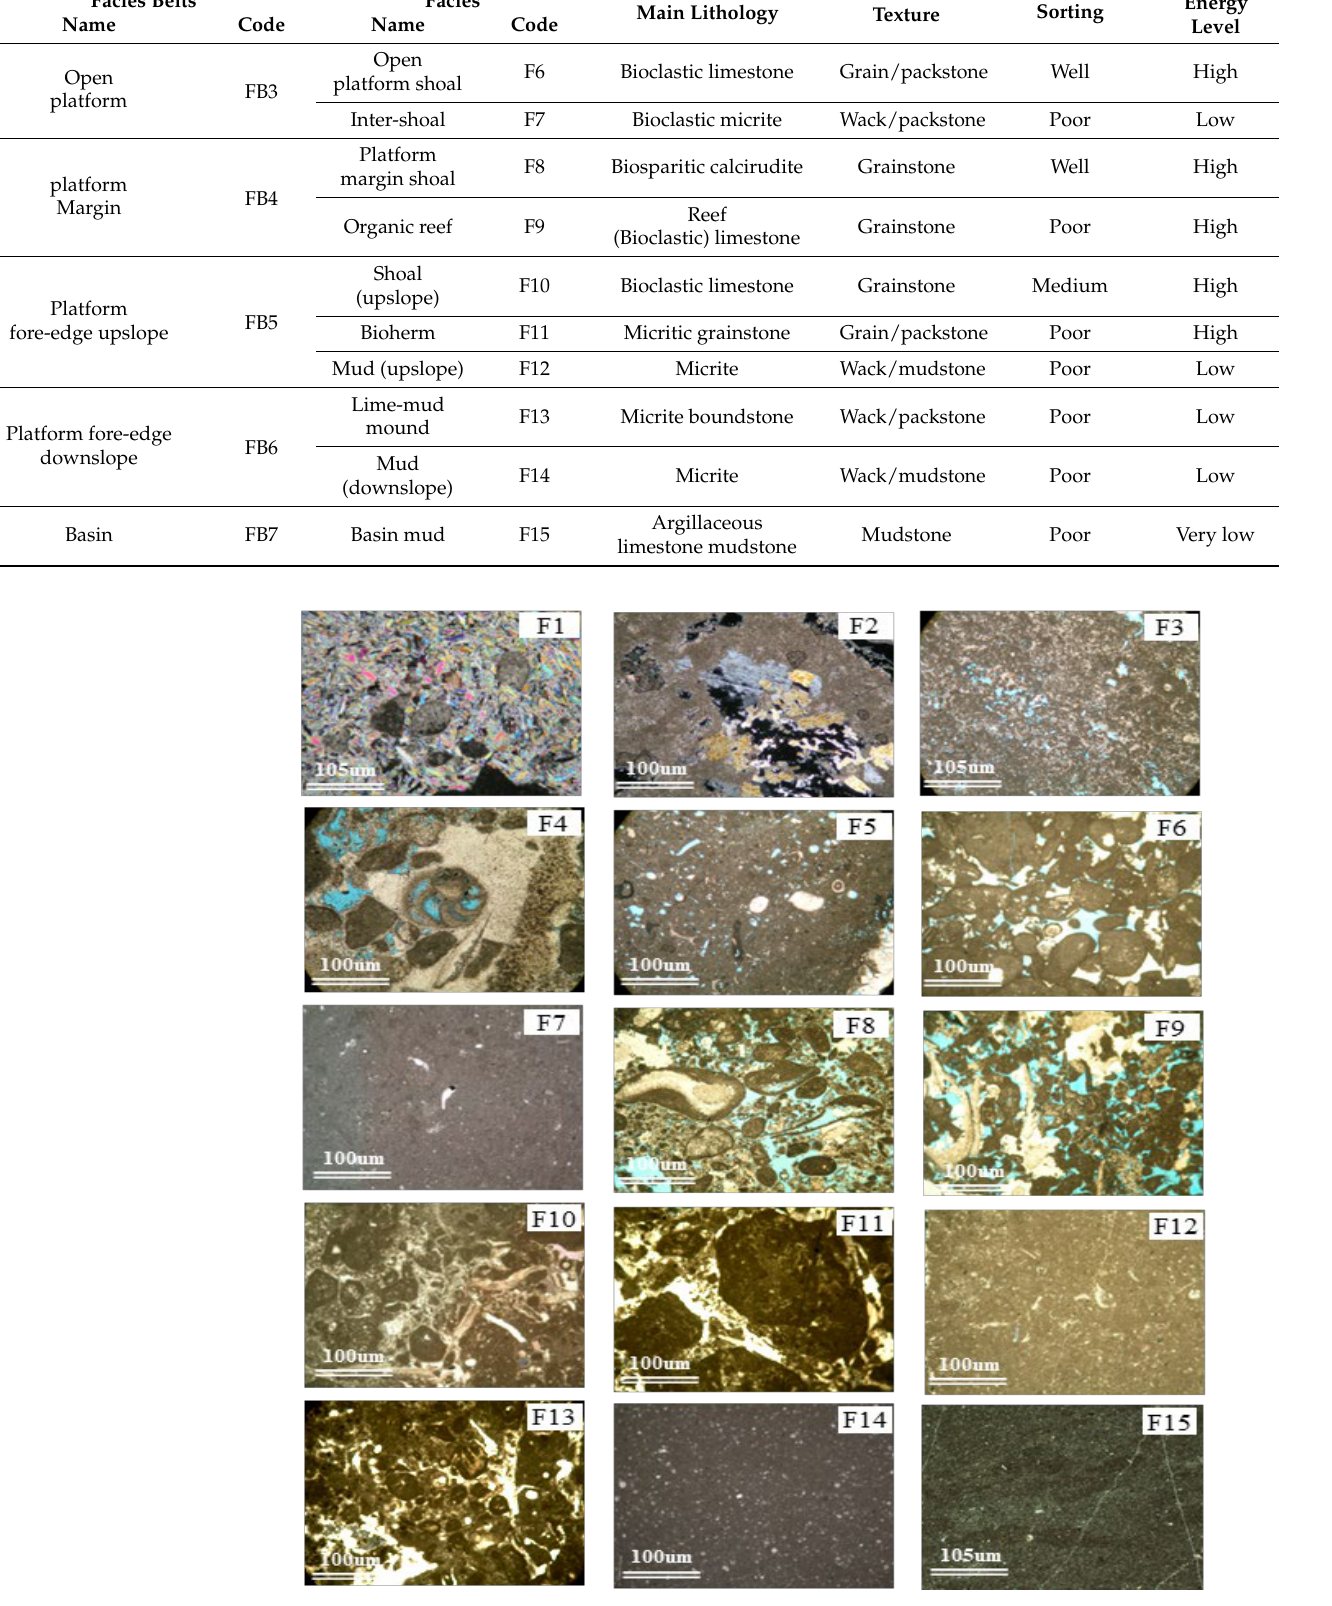
Figure 3. Photomicrographs of 15 facies identified in the Callovian-Oxfordian stage.